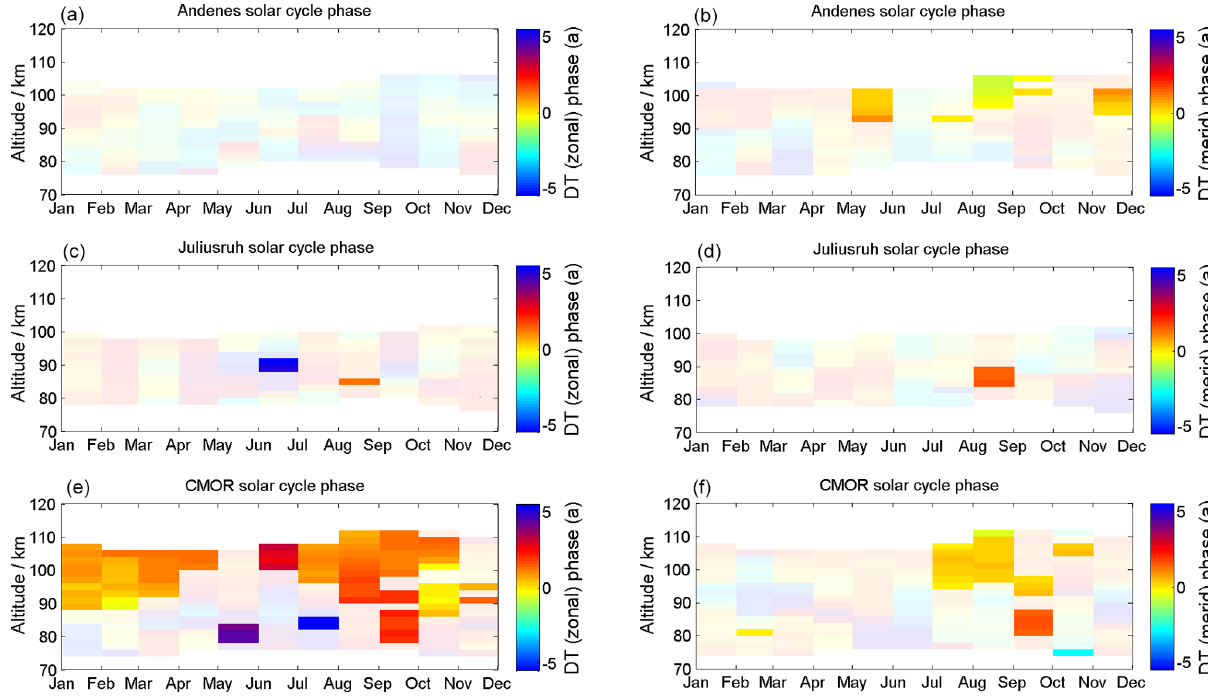
Figure A2. Same as Fig. A1 but for the diurnal component.